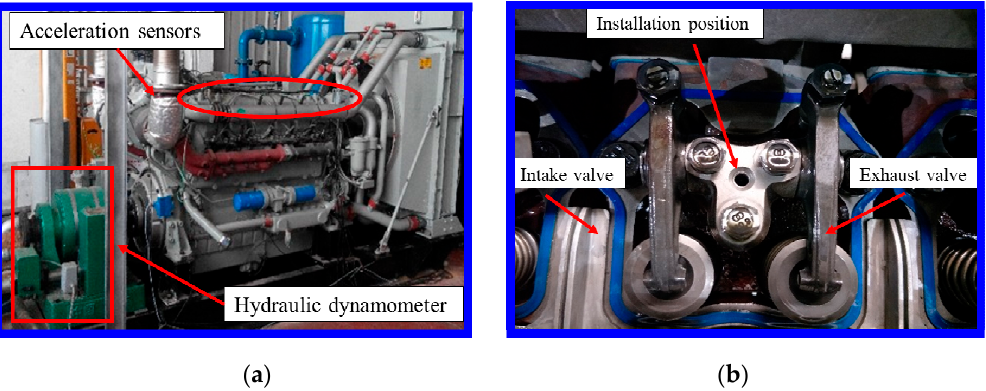
Figure 1. Diesel engine and valve: ( a ) V-type 12 cylinder diesel engine and sensors; ( b ) installation position and intake and exhaust valve.